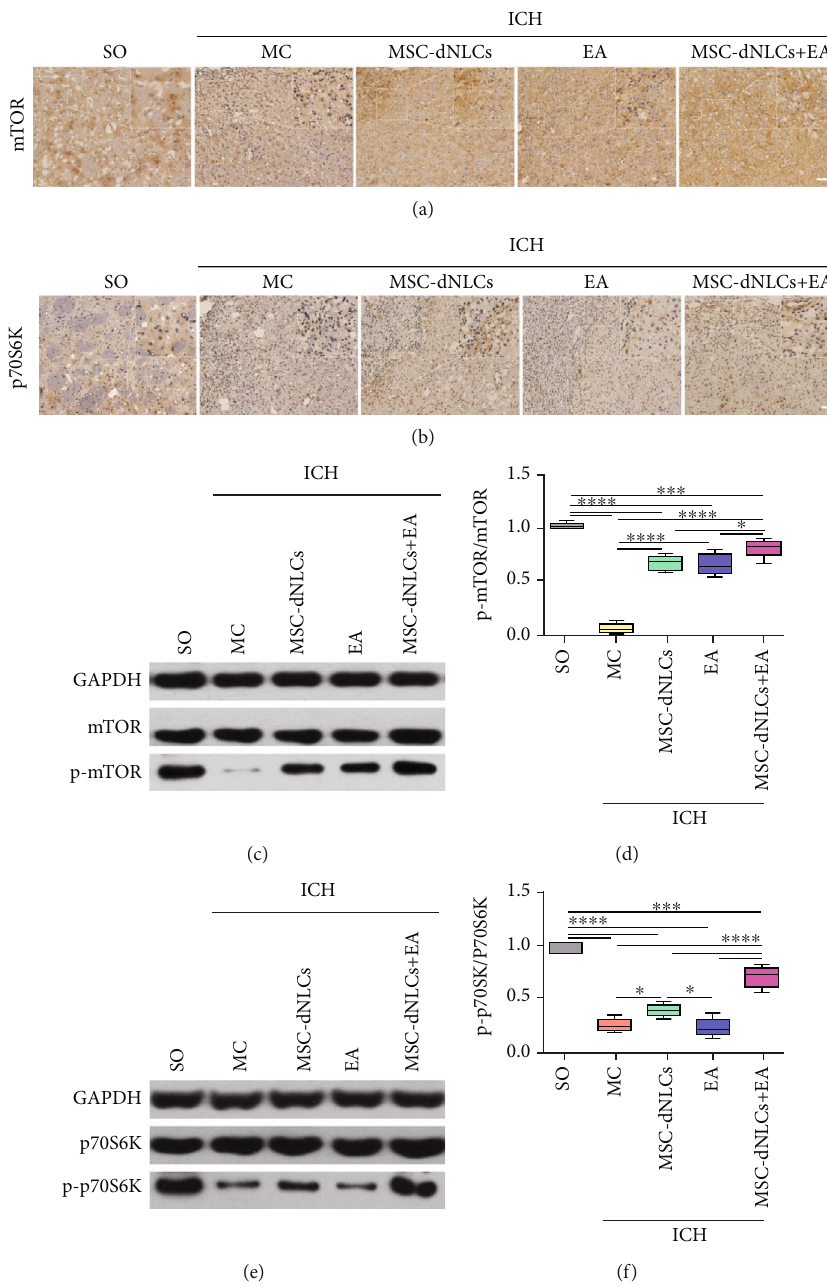
Figure 7: The levels of total and phosphorylated mTOR and p70S6K proteins in di ff erent groups. (a, b) Representative images of mTOR (a) and p70S6K (b) immunohistochemistry in the ipsilateral striatum of brain tissues from di ff erent groups. Scale bar = 100 μ m . (c, d) Representative results (c) and quantitative analyses (d) of western blotting showed the level of the phosphorylated mTOR protein in di ff erent groups ( n = 5 animals per group; ∗ P < 0 : 05 , ∗∗∗ P < 0 : 001 , and ∗∗∗∗ P < 0 : 0001 ). (e, f) Representative results (e) and quantitative analyses (f) of western blotting showed the level of the phosphorylated p70S6K protein in di ff erent groups ( n = 5 animals per group; ∗ P < 0 : 05 , ∗∗∗ P < 0 : 001 , and ∗∗∗∗ P < 0 : 0001